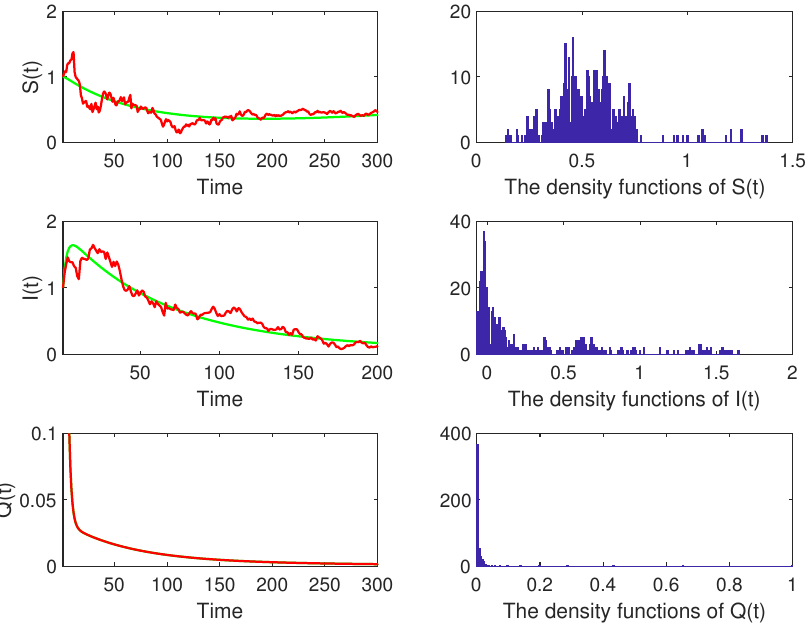
Figure 1. The red lines describe the solution of system (3) and the green lines stand for the solution of the corresponding system (2). The right pictures are the histogram of the density function for S , I , and Q